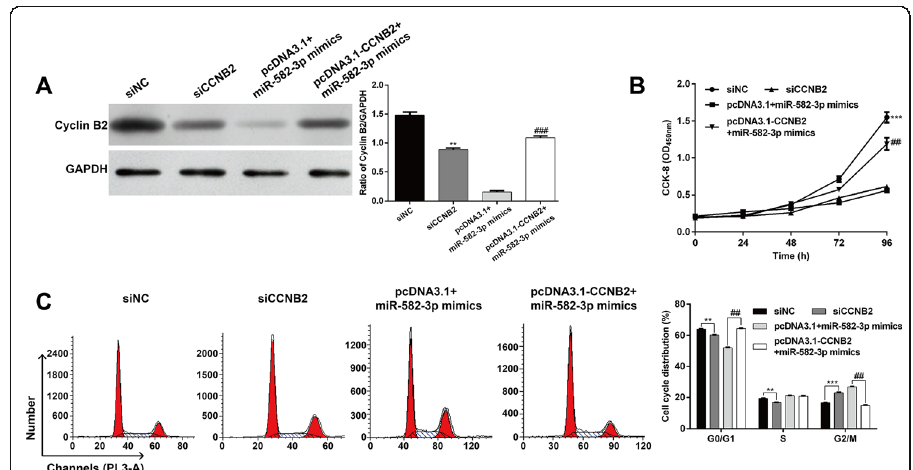
targeting CCNB2. THP-1 cells were transfected with siCCNB2, siNC, miR-582 – 3p mimics + pcDNA3.1 or miR- 582 – 3p mimics + pcDNA3.1-CCNB2. a The protein level of cyclin B2 expression was detected using western blot. b CCK8 assay was performed to evaluate cell proliferation at the indicated times following transfection. c THP-1 cells were stained with PI and subjected to flow cytometry analysis, followed by quantification of cell cycle distribution. Data are presented as means ± SD from three independent experiments. ** p < 0.01,